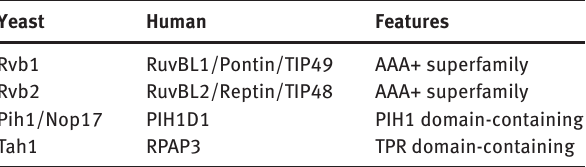
Table 1 The components of R2TP in yeast and human.